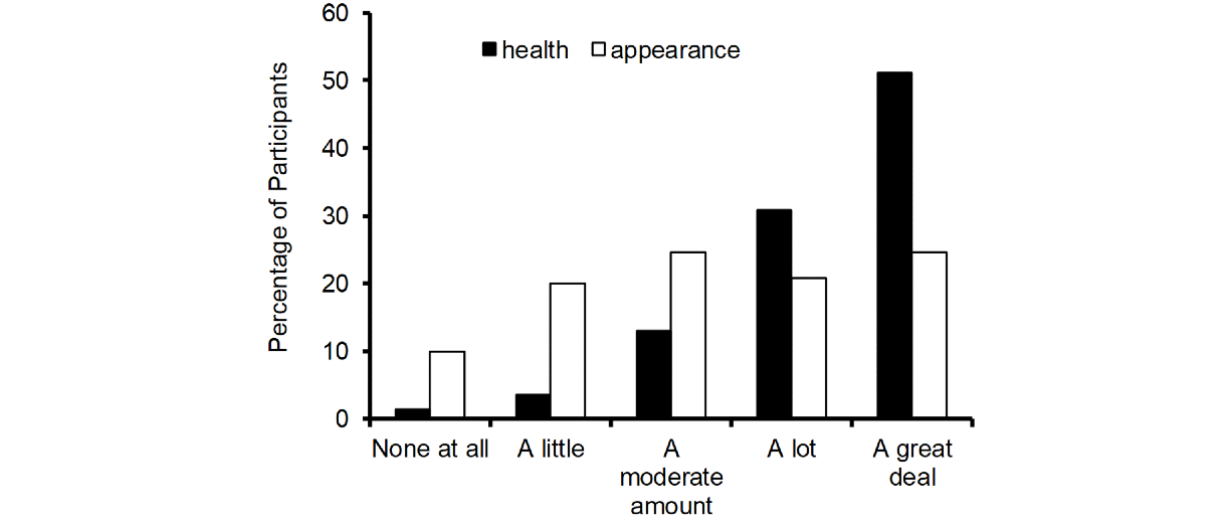
Figure 3. Relative motivation of health and appearance for the consumption of fruit and